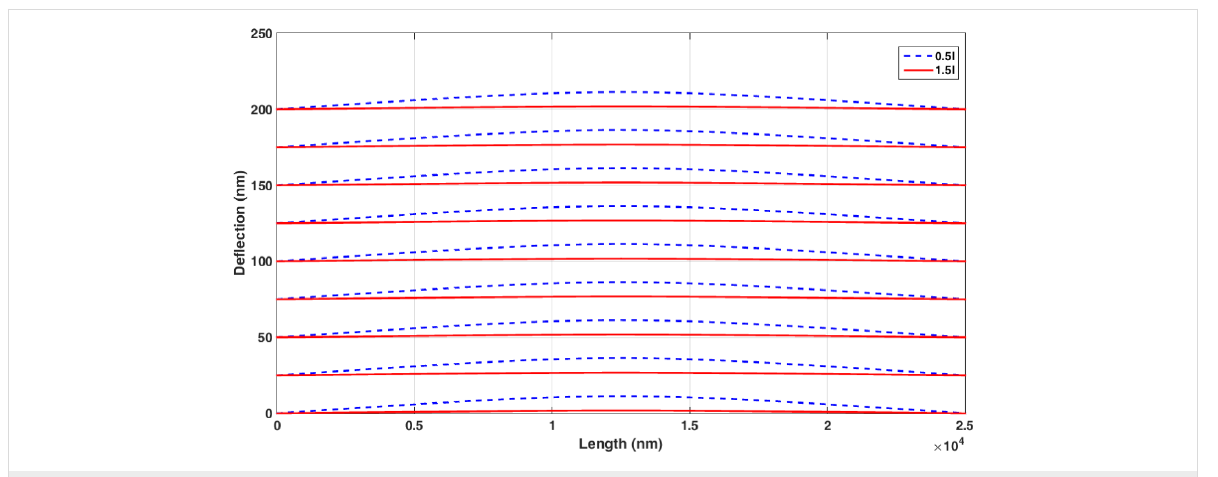
Figure 13: Manipulation of the nonclassical Timoshenko model for 0.5 l and 1.5 l .